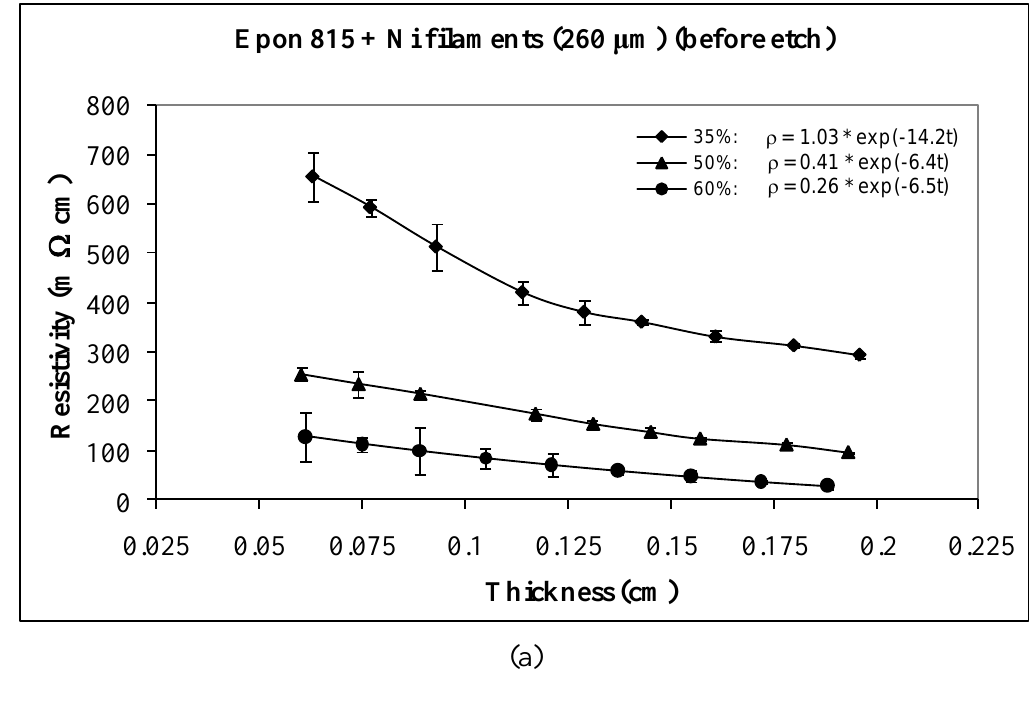
Figure 11. Thickness-dependent resistivity of Epon 815C ( a ), and 830 ( b ) films filled 35%, 50%, 60% by volume with unetched nickel filaments (260 